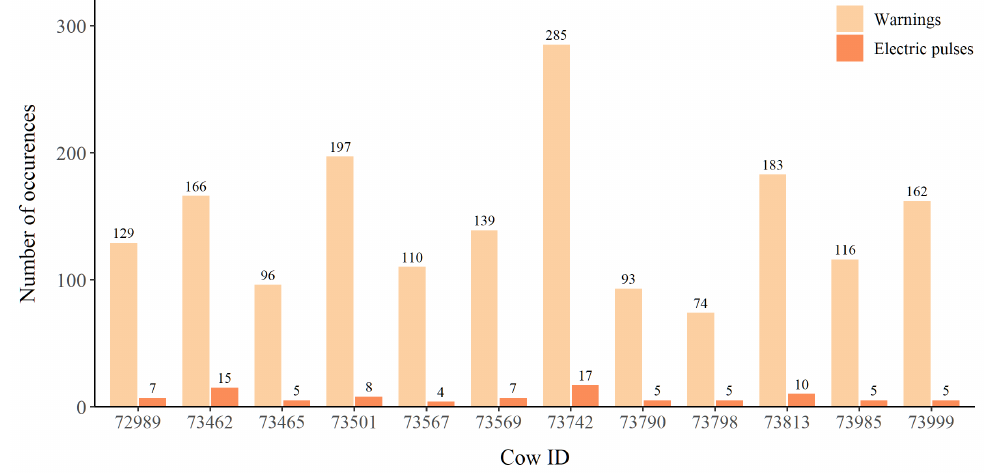
Figure A9. The number of auditory warnings and electric impulses that each individual received throughout the 139-day experiment, excluding those received on days where a social panic reac- tion